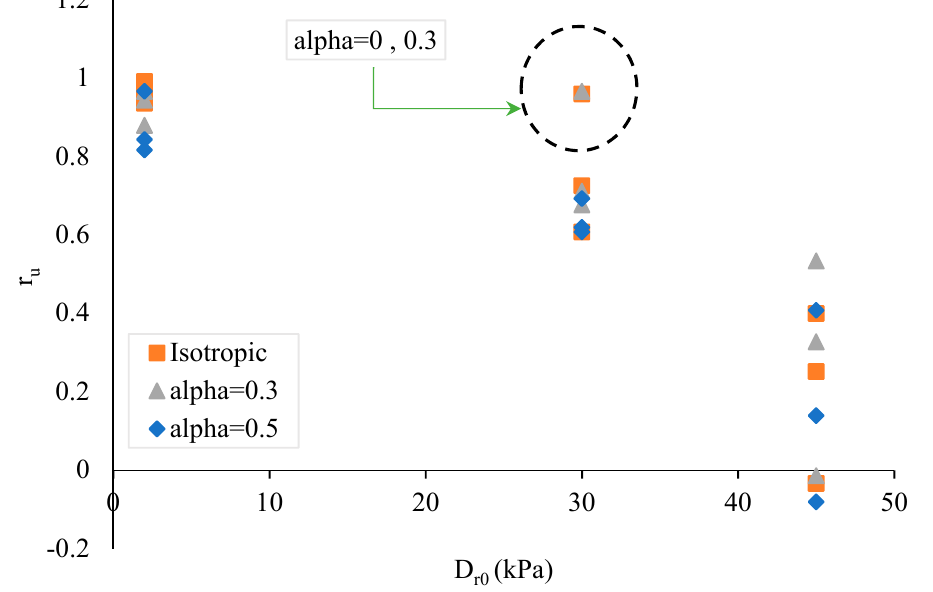
Figure 13. Pore water pressure ratio versus mean effective stress and effective confining pressure in isotropic and anisotropic stress conditions.